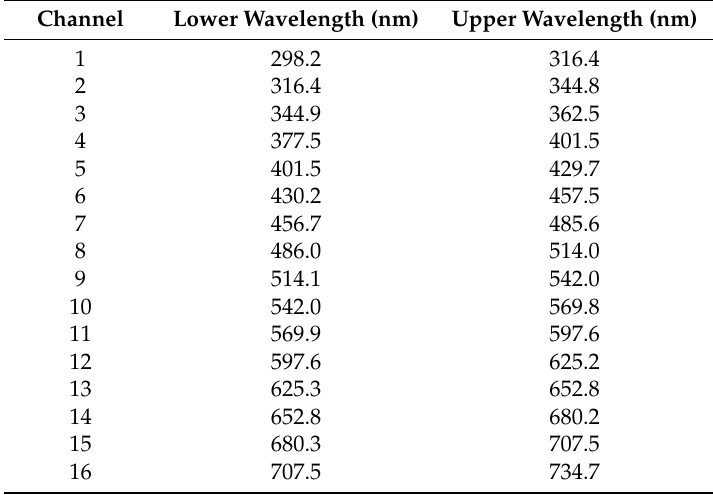
Table 2. Fluorescence measurement channels (Ch) and wavelength